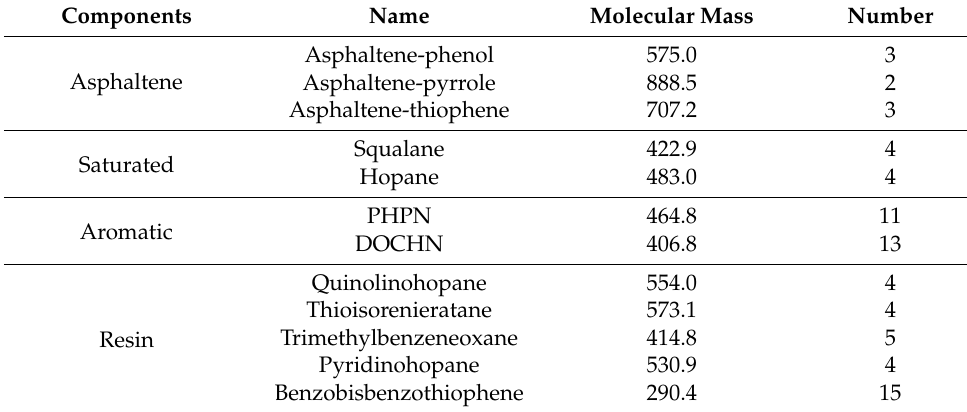
Table 1. Molecular compositions of asphalt binder model.